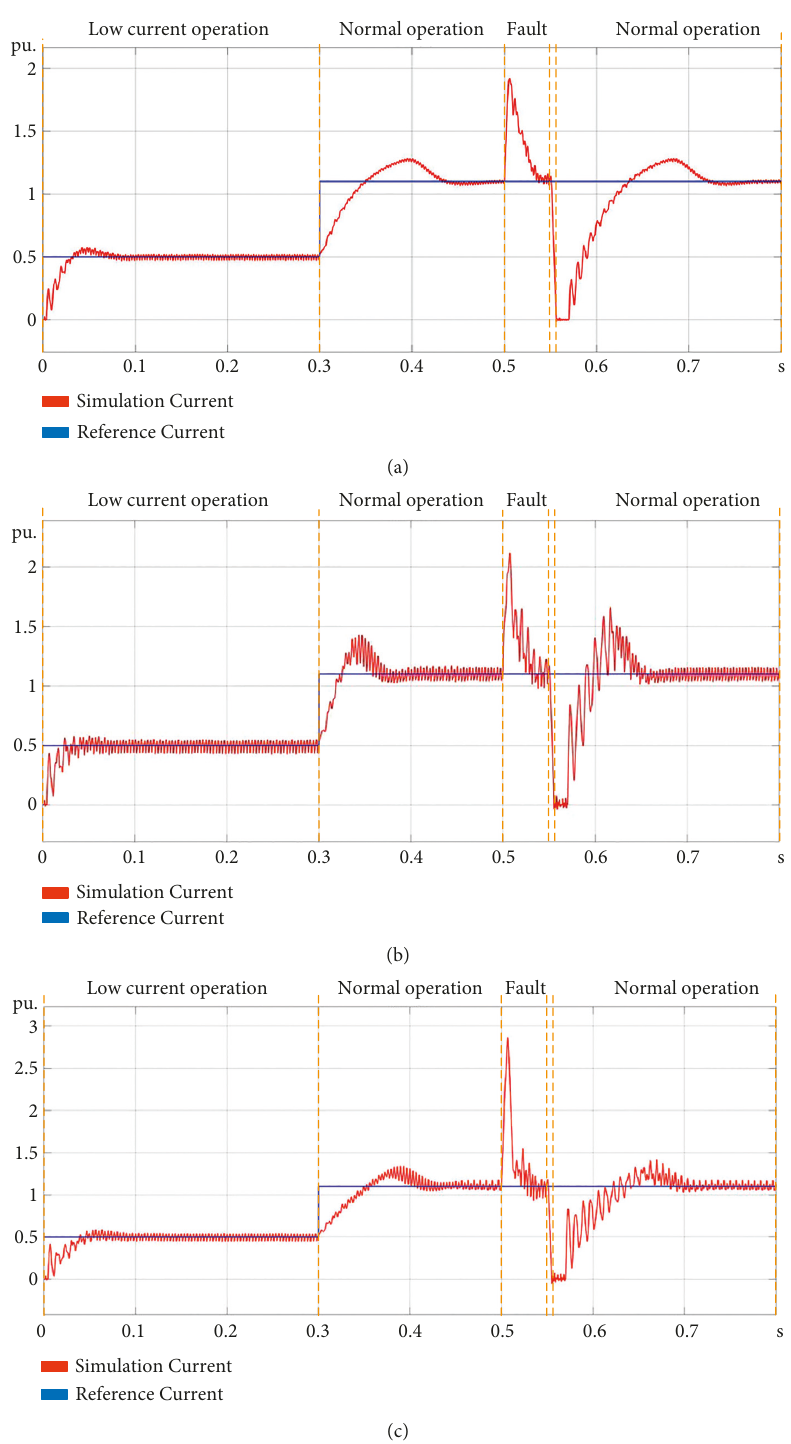
Figure 3: Current of the HVDC transmission line. (a) A 250kV HVDC transmission line (250 kV, 500kVA, 2 kA), (b) a 450V HVDC transmission line (450 V, 750VA, 1.667A), and (c) a 500V HVDC transmission line (500V, 750 VA,